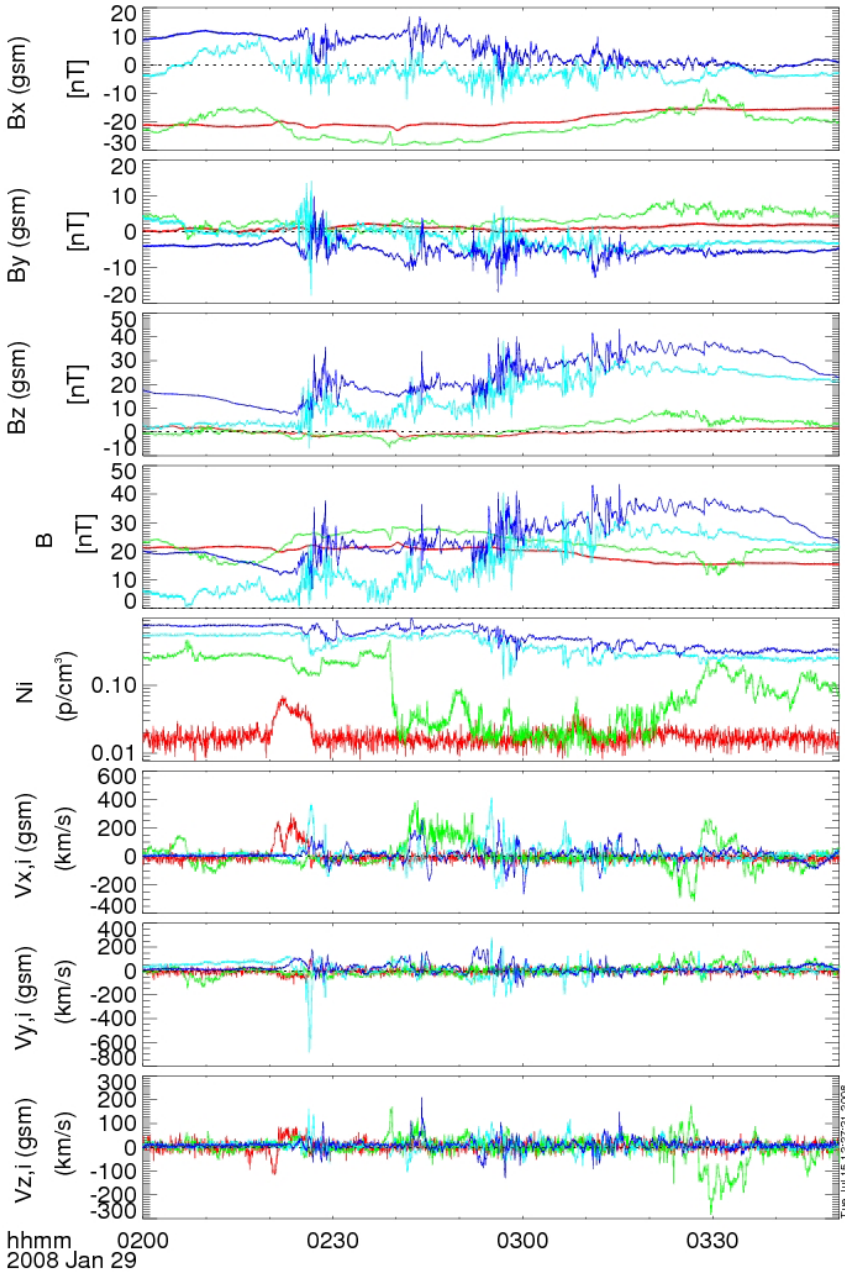
Fig. 2. From top to bottom: Three components and modulus of the magnetic field, Ion density and three components of the ion velocity for four of the THEMIS (traces from THA not displayed). Same color code as for Fig.